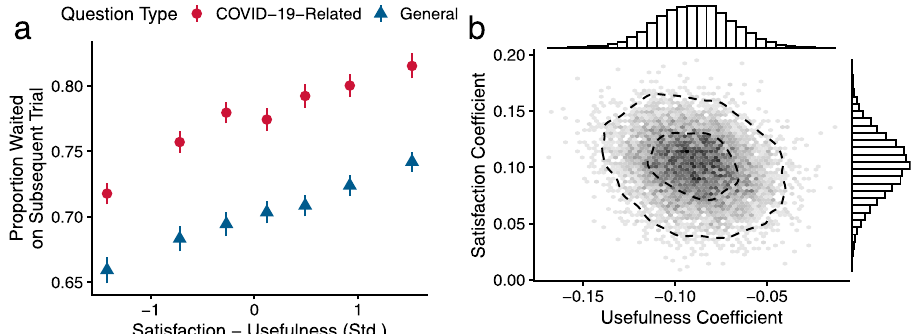
Fig. 4 Prediction errors in fl uence information-seeking on the subsequent trial. a Prediction errors, de fi ned as the difference between actual satisfaction with answers minus usefulness expectations engendered by the question, determined waiting for choices on the subsequent trial. The in fl uence of prediction errors testi fi es to participants ’ use of the average value of information in making waiting choices. Data presented as mean values ±1 SEM; n = 4754 participants. b Posterior distribution of the coef fi cients for usefulness expectations and satisfaction in a multilevel regression model predicting waiting choices on the subsequent trial. The satisfaction coef fi cient is signi fi cantly positive, while the usefulness coef fi cient is signi fi cantly negative. Together, the two coef fi cients re fl ect the in fl uence of prediction errors. Dashed contours denote 95 and 50% posterior densities. Source data are provided as Source Data fi